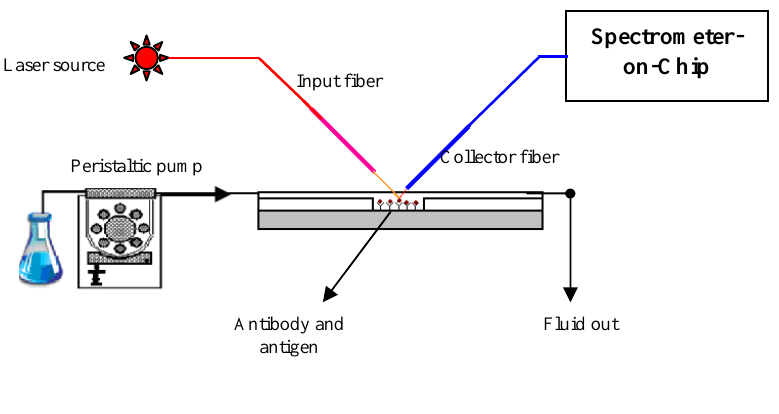
Figure 7 : Schematic of Bio-optical fluorescence detection